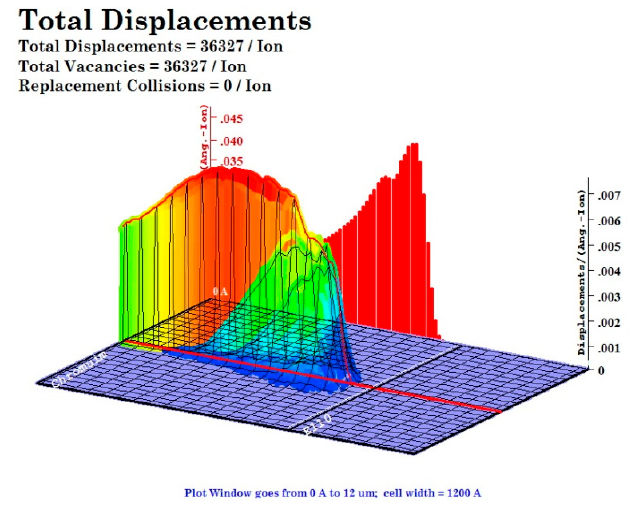
Figure 19. Damage caused by 95 MeV Cs in E110 alloy, coated with 8 µm Cr thin film.